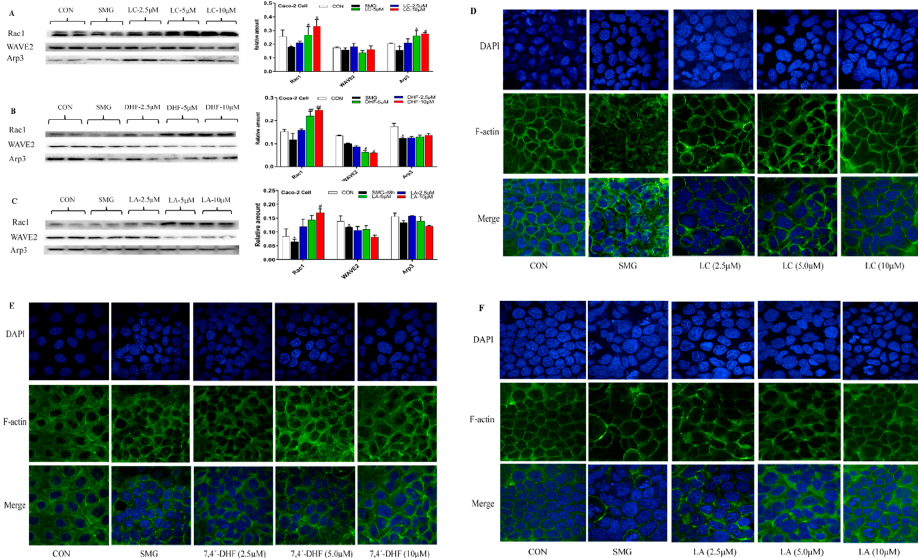
Figure 5. LC ( A ),7,4’-DHF ( B ) and LA ( C ) regulated the expression of Rac1-WAVE2-Arp3 pathway proteins in SMG-treated Caco-2 cells. Effect of LC ( D ),7,4’-DHF ( E ) and LA ( F ) on rearrangement of F-actin. Note: * p < 0.05, compared with CON group. # p < 0.05 and ## p < 0.01, compared with SMG group. The relative expression levels of proteins were expressed as the ratio of gray value of the target band to that of total proteins in the same sample. The total protein gel was shown in Supplementary Figure S7.